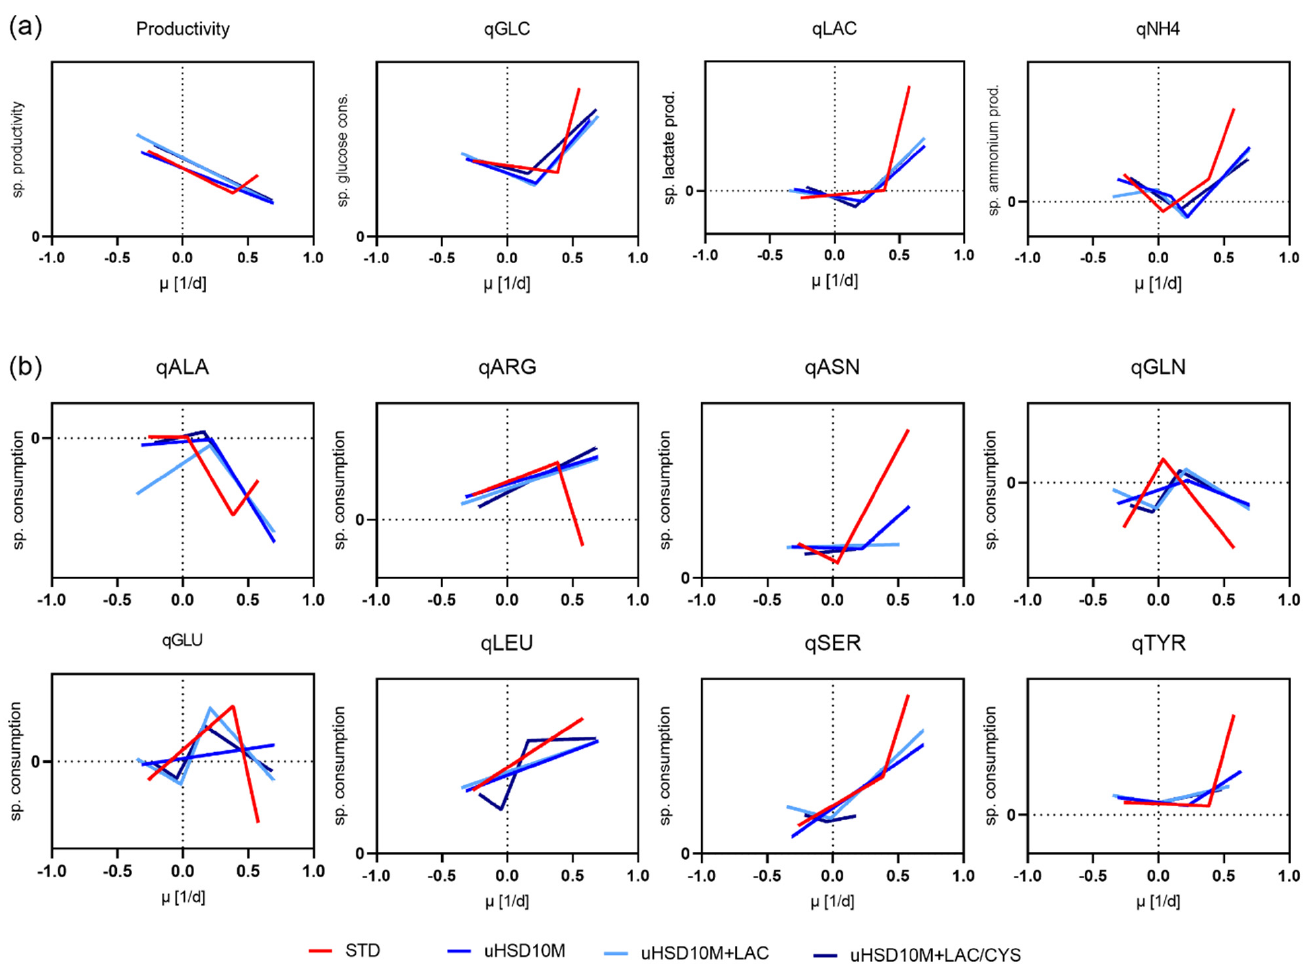
Figure 6. Comparison of segmented linear modeling for productivity and specific rates of consump- tion or release of glucose, lactate and ammonium ( a ) and for selected amino acids ( b ) for the processes: standard (2), HSD10M without supplementation (5), HSD10M with LAC supplementation (3) and HSD10M with LAC/CYS (2) supplementation. The number in the brackets shows the number of runs which were used for this analysis. Data points were cleaned before segmented modeling; therefore, some models are reduced, e.g., for the model of qSer for HSD10M + LAC/CYS. Some models resulted in less than three phases due to the F-Test, which avoids overfitting. ALA = alanine; ARG = arginine; ASN = asparagine; GLN = glutamine; GLU = glutamate, LEU = leucine; SER = serine; TYR = tyrosine. The prefix q describes the specific rates of consumption or release. STD, standard process with seeding density of 0.7 × 10 6 cells/mL; HSD10M, process with the seeding density 10 × 10 6 cells/mL; +LAC, supplemented with lactate; +LAC/CYS, supplemented with lactate and